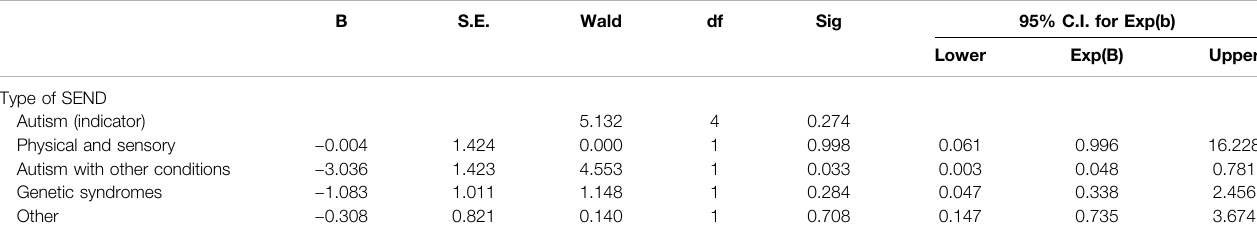
TABLE6| Parameterestimatesfortheeffectoftypeofsettingonthelikelihoodofparentsloweringtheirratingfrom “ verypleased ” to “ pleased ” inrelationtosocialdistancing measures implemented by their child ’ s